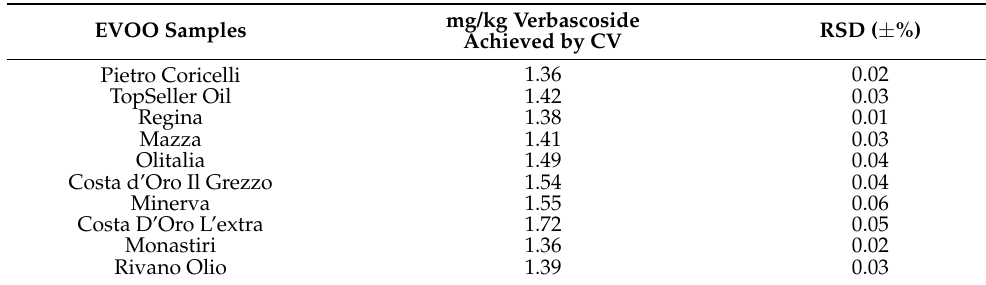
Table 5. Concentrations of verbascoside ( n = 3) in commercial EVOO obtained by the voltammetric